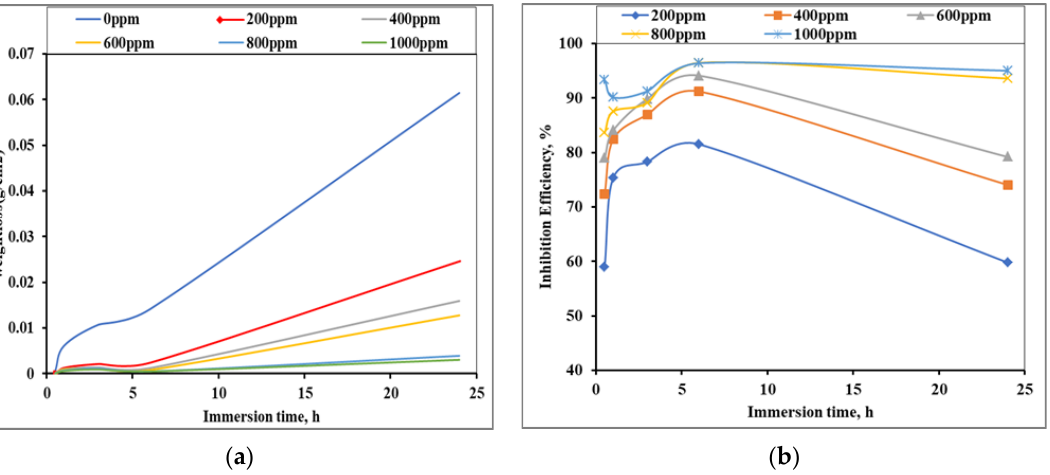
Figure 4. Effect of immersion time on the variation of ( a ) weight loss and ( b ) inhibition efficiency for the corrosion of MS dipped into acid and different concentrations of inhibitor solution at room temperature.